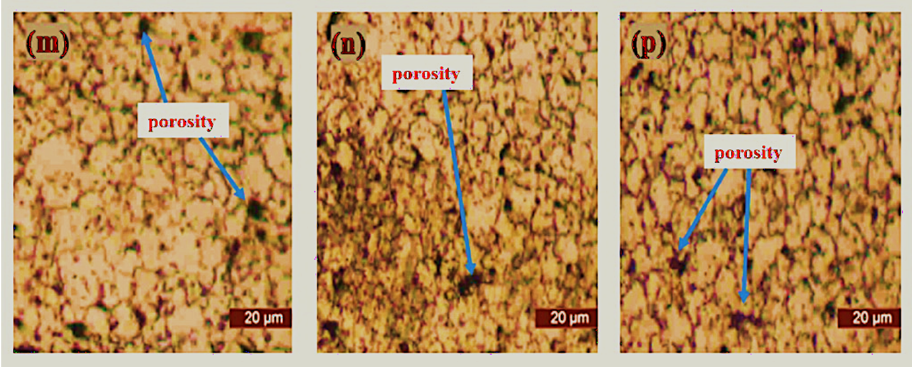
Figure 12. Microstructure of sintered samples ( m ) S13, ( n ) S14, and ( p ) S15.